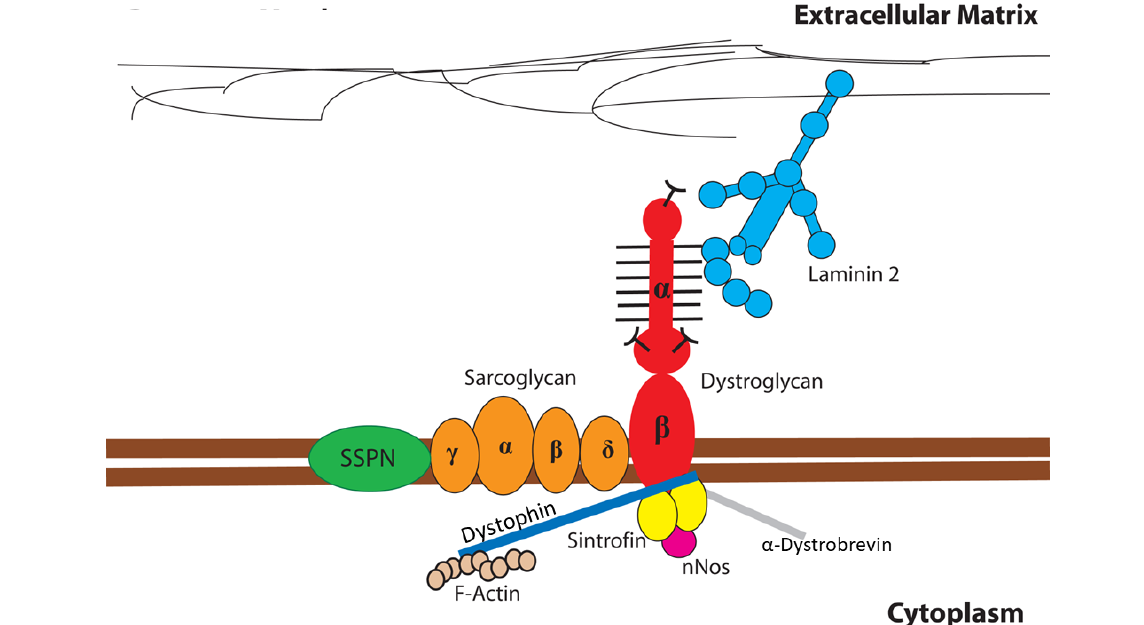
Figure 3. Scheme of genes implicated in CMDs and their localization in skeletal muscle cell. Adapted from Zambon and Mutoni 2021. LAMA2, Laminin-2 protein; COL6A1, COLA2 and COL6A3, α-chains of Callagen VI monomers and tetramers; ITGA7, integrin α-7; ITGA9, integrin α-9; SEPN1, Selenoprotein 1; SYNE, Spectrin Repeat Containing Nuclear Envelope Protein 1; LMNA, Laminin a/c; TRAPPC11, Transport protein particle 11; GOSR2, Golgi SNAP receptor complex 2; DAG1, Dytroglycan; POMT1, Protein O-mannosyl-transferase 1; POMT2, Protein O-mannosyl- transferase 2; POMGNT1, Protein O-mannose β1,2-N-acetylglucosminytranferase 1; POMGNT2, Protein O-mannose β1,4-N-acetylglucosminytranferase 2; TMEM 5, transmembrane protein 5; RXYLT1, ribitol-5-phosphate xylosyltransferase 1; B4GAT1, β1,4- glucuronyltransferase; B3GALNT2, β1,3-N_acetylgalactosaminyltransferase; POMK, Protein O-mannose Kinase; FKTN, Fukutin; FKRP, Fukutin related protein; LARGE1, like-acetylglucosaminyltransferase/LARGE xylosyl-and glucoronyltransferase 1; ISPD, isoprenoid synthase domain-containing protein; CDP-ribitopyrophosphorylse